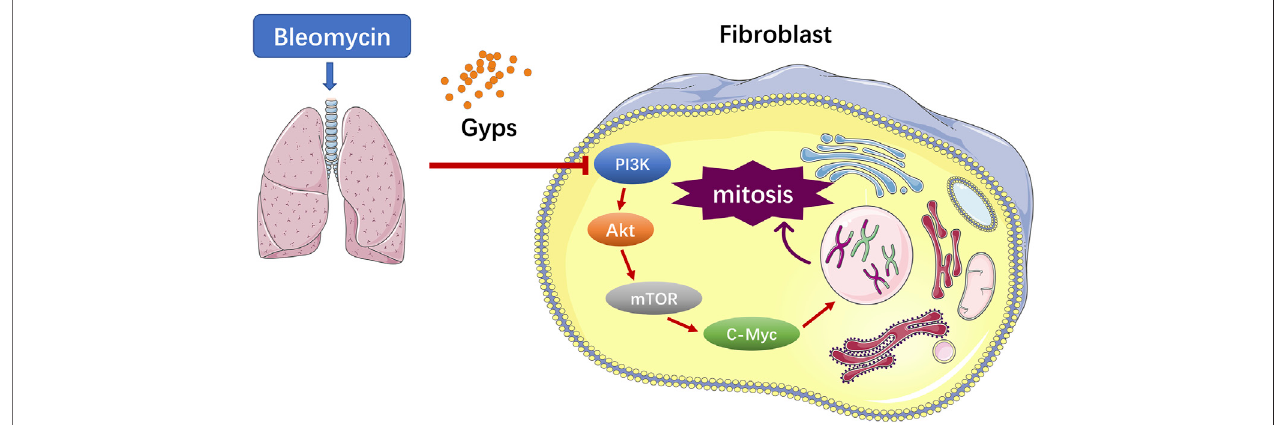
FIGURE 6 | Potential mechanism of Gyps on PF mice induced by BLM. Gyps (cid:1)